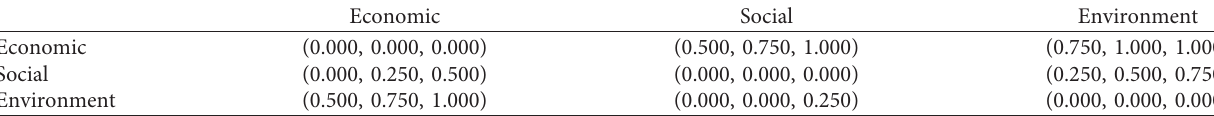
Table 34: Comparison matrix of linguistic variable of sustainability dimensions in fuzzy condition.